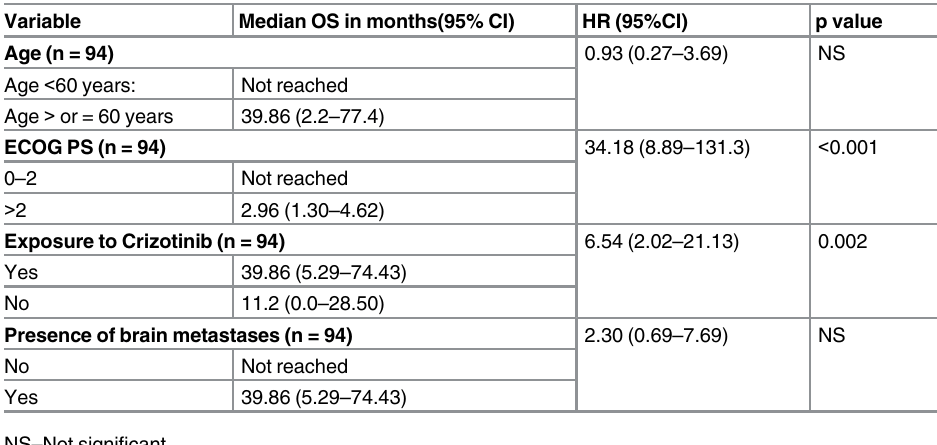
Table 6. OS and Prognostic